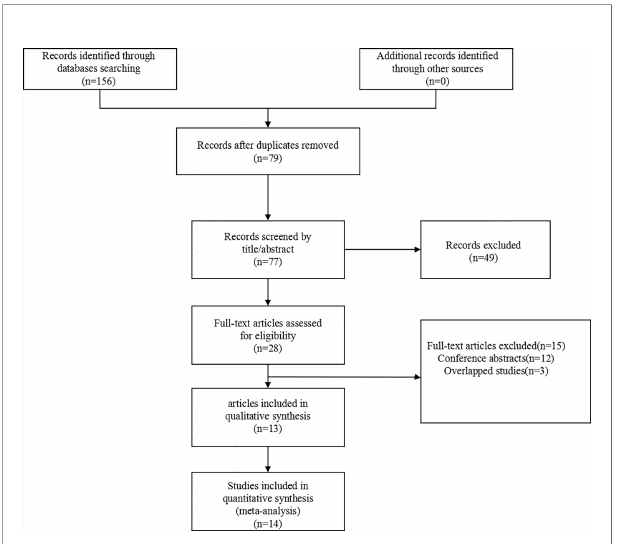
FIGURE 1 | Flow chart of the literature